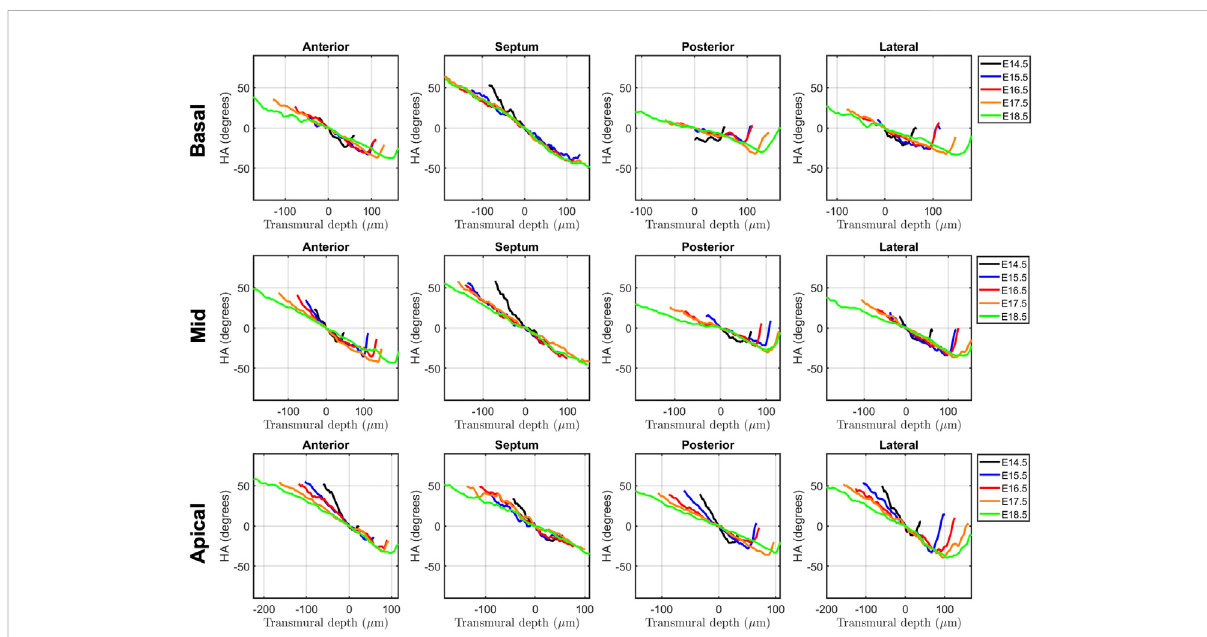
FIGURE 5 Left ventricular (LV) transmural pro fi les of helical angle (HA) across anterior, septal, posterior and lateral walls, from endocardium (negative transmural depth values) towards the epicardium (positive transmural depth values), at basal (top), mid (middle) and apical myocardium (bottom), at E14.5, E15.5, E16.5, E17.5 and E18.5 days of development. Solid lines represent age-group mean. Transmural depth of 0 µm represents the position where myocyte aggregates have a HA of 0 °